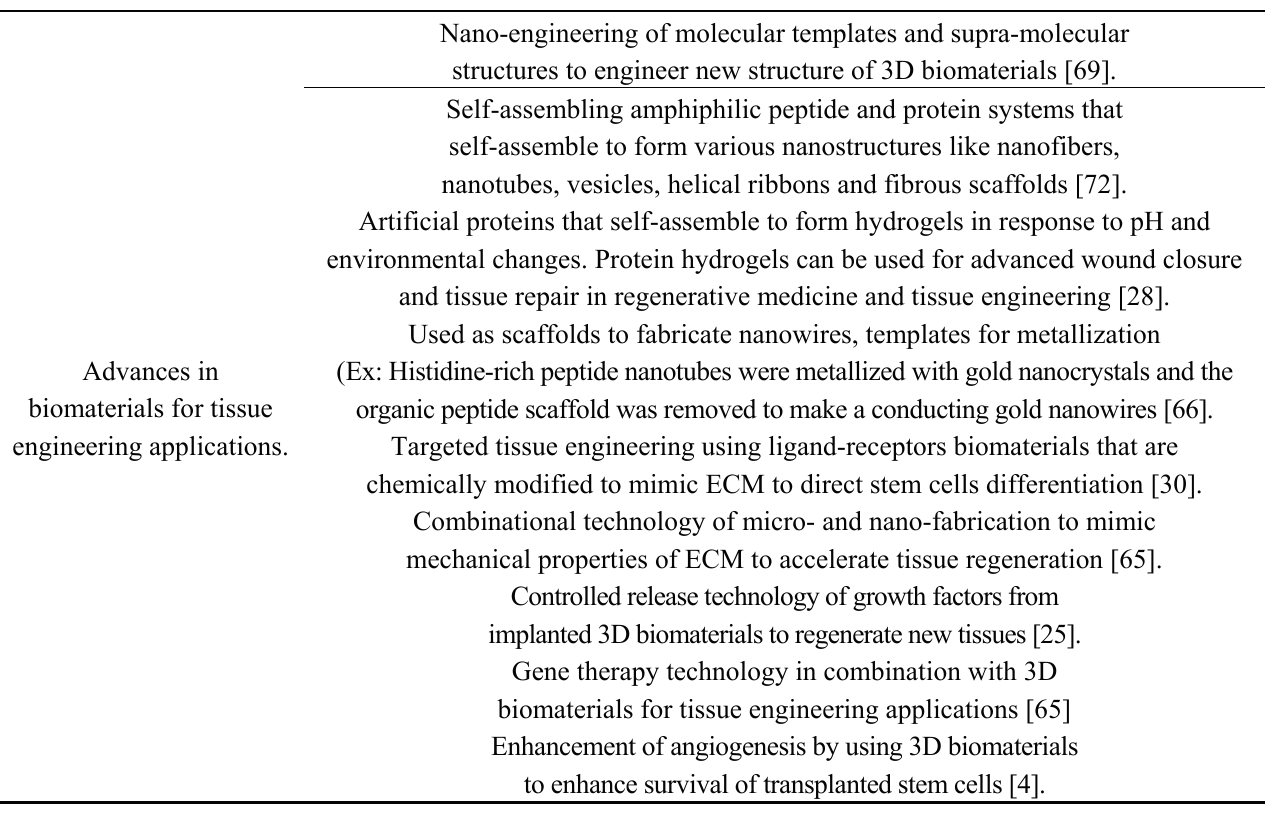
Table 3. Advances in 3D biomaterials for tissue engineering